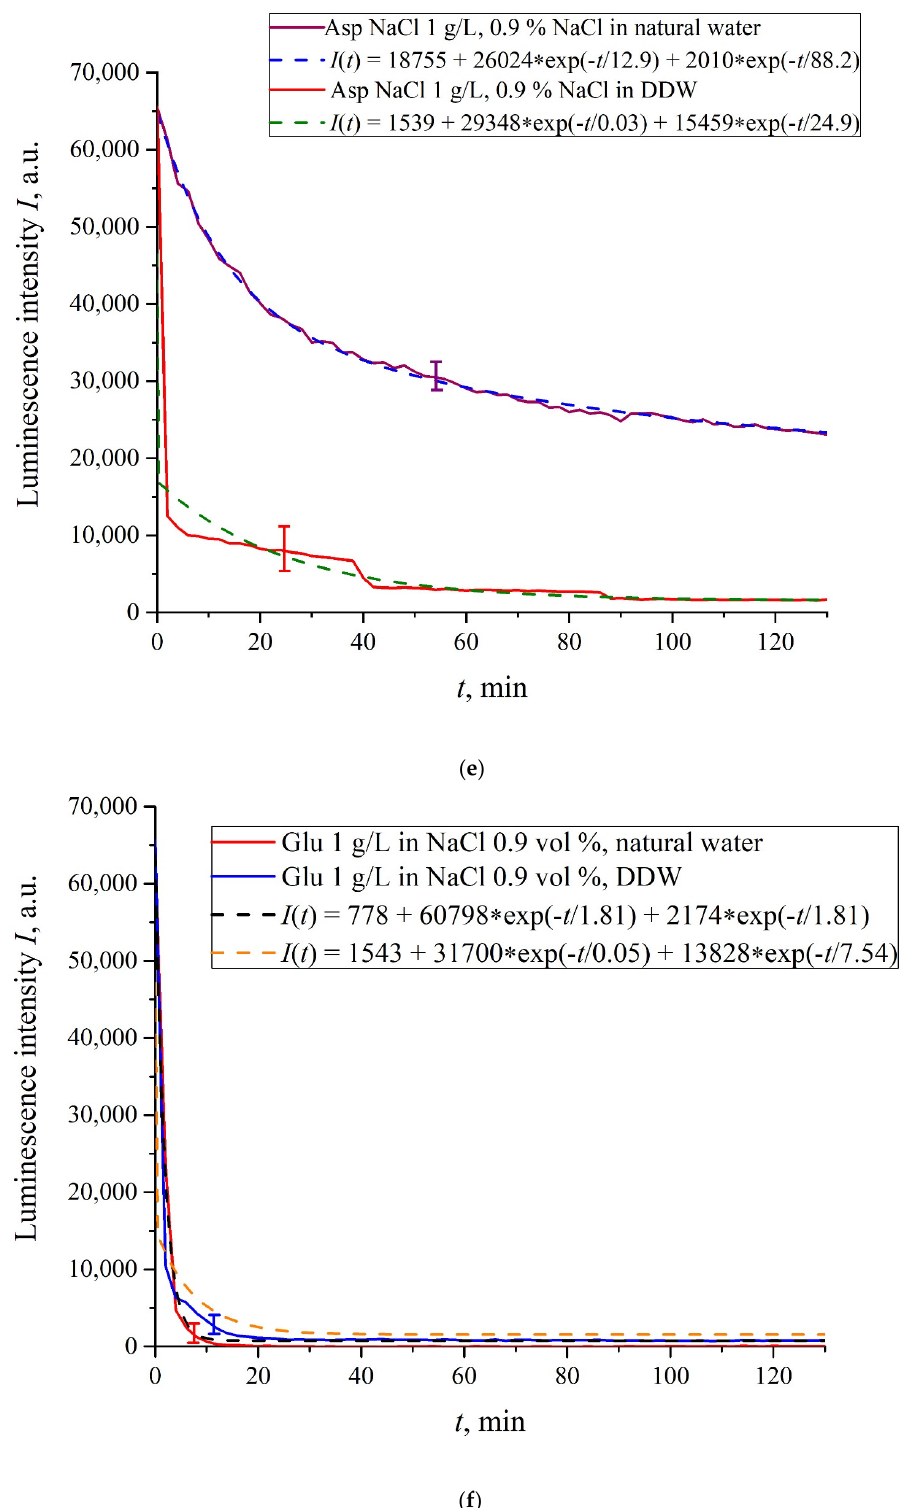
Figure 6. Luminescence intensity I ( t ) vs. soaking time in ordinary water-based and DDW-based saline solutions (0.9 vol.% NaCl) for the following amino-acid suspensions. ( a ) Lysine; ( b ) Histidine; ( c ) Glycine; ( d ) Alanine; ( e ) Aspartic acid; ( f ) Glutamic acid.